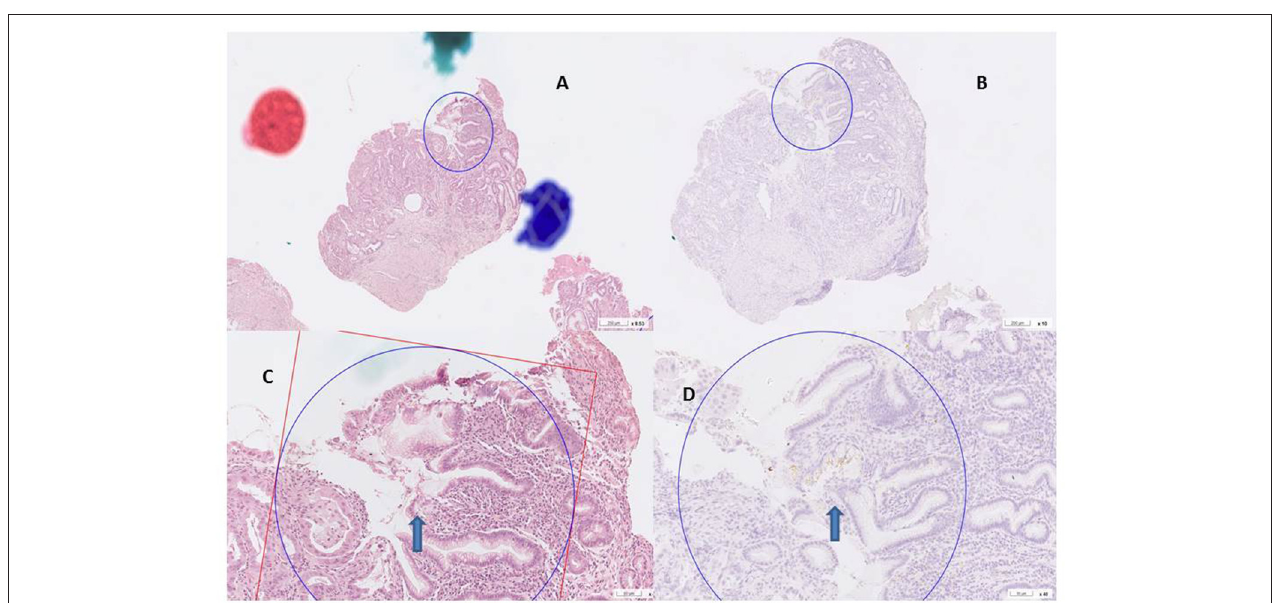
FIGURE 2 | H. pylori infection H&E and antibody stain. (A,B) H& E stain, curved bacilli within the mucus of epithelim (arrow). (C,D) anti H. pylori antibody stain (arrow).